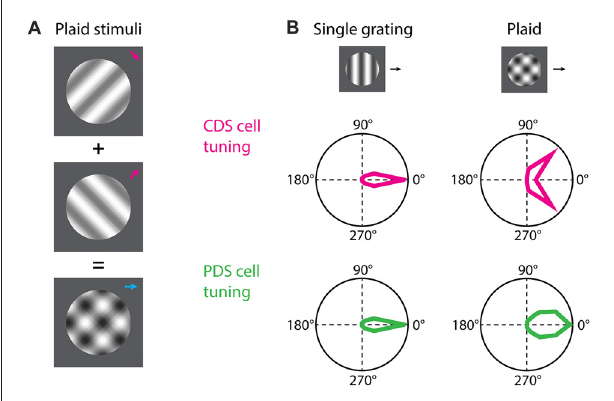
FIGURE 1 | Component and pattern direction-selective (PDS) cells. (A) For the study of component direction-selective (CDS) and PDS cells the common visual stimulus employed is plaids consisting of two drifting gratings superimposed additively and offset by an angle. (B) Both CDS and PDS cells are tuned for the direction of motion of a single drifting grating. When a plaid stimulus is presented the predicted behavior of a PDS cell is that the neuron integrates the motion signals and responds to the plaid as it does to the individual grating but with broader tuning. The CDS cells responds to the individual grating components of the plaid as if they were presented alone. Polar plots in (B) are based on Smith et al.